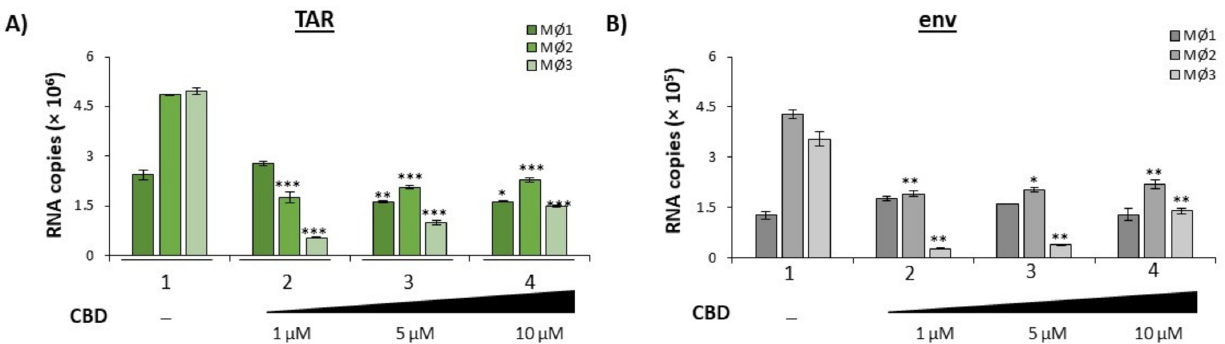
Figure 3. CBD lowers viral RNAs in EVs released from HIV-1 infected primary macrophages. Primary PBMCs were purchased (Precision For Medicine, Frederick, MD, USA) and cultured in vitro first with PMA/GM-CSF for 3 days to obtain macrophages, and were then infected with HIV-1 89.6 strain (MOI: 10) for 12 days. The macrophages were treated with PMA and GM-CSF during the infection period (added every 3 days into the fresh media). On day 12, all cells were treated with cART (4 antivirals) and kept in culture for another 3 days. On day 15, media was removed, and CBD was added for 5 days (1, 5, 10 µ M; at 0 and 48 h). Supernatants were then isolated, and exosomes were enriched using NT80/82 beads overnight at 4 ◦ C. The NT80/82 beads were then pelleted, RNA was isolated, followed by RT-qPCR analysis for ( A ) TAR and ( B ) env viral RNA transcripts. Data shown are an average of 3 replicates. Student’s t -test was used for statistical analysis, where * = p < 0.05, ** = p < 0.01, and *** = p <